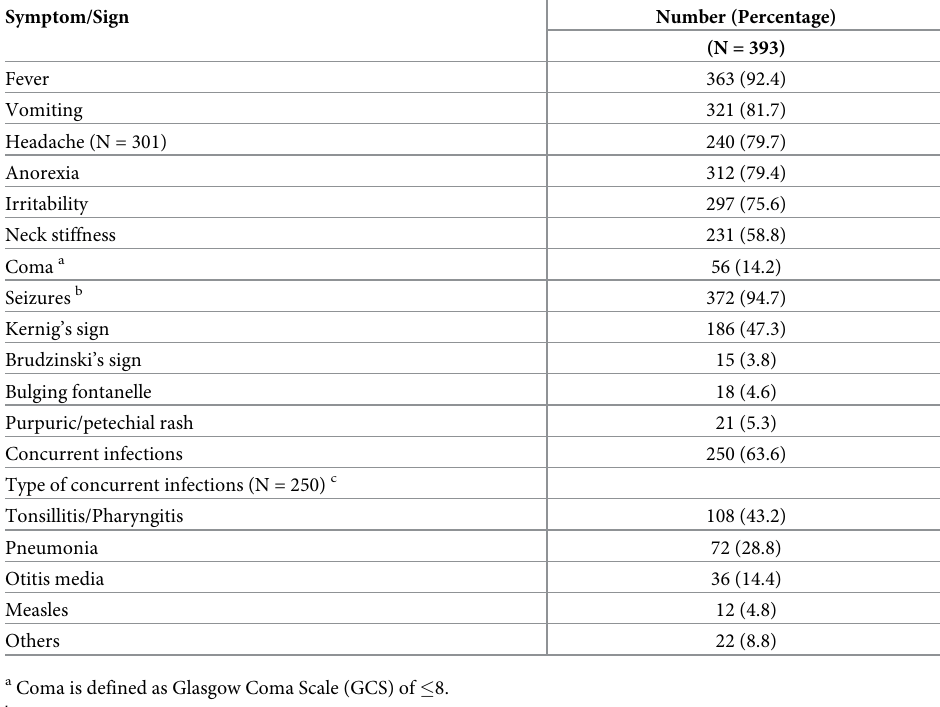
Table 2. Clinical features on admission in the 393 ABM